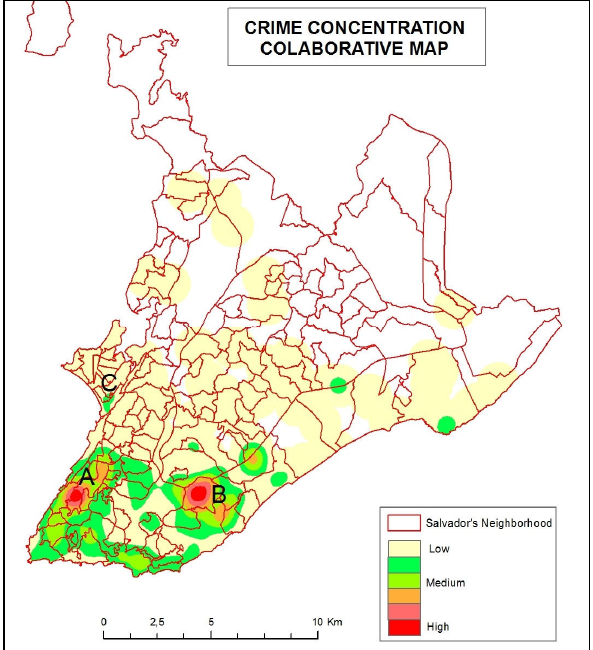
Figure 5. Map of concentration of crimes to the transient registered at the website “Onde Fui Roubado”. In order to ascertain the greatest differences found between the two sources of crime data, the technique of map algebra was conducted. The resulting map (Figure 6) shows areas where SSP data indicate higher crime concentration (in red) and areas wher "Onde Fui Roubado” website indicates higher concentration (in pink).